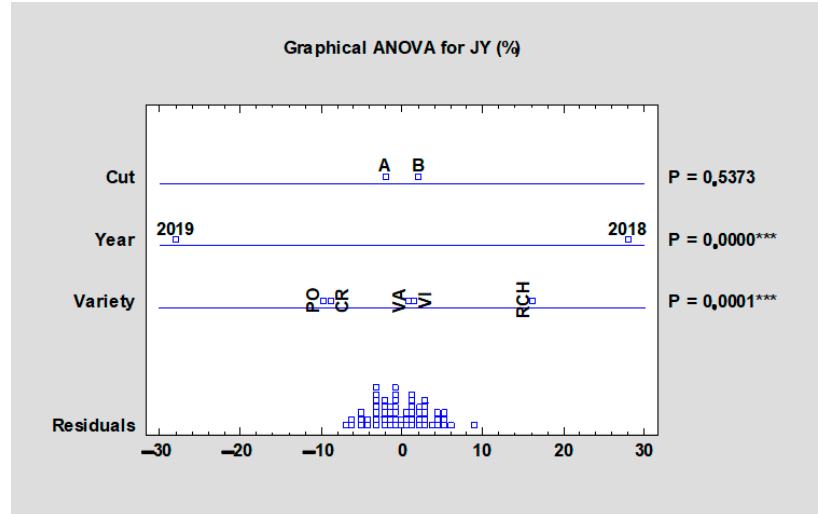
Figure 3. Effect of the experimental year, cultivar, and term of the harvest on the mean juice yield of all rhubarb cultivars. Abbreviations: PON, ´Poncho´; CRE, ´Canadian Red´; VAL, ´Valentine´; RCH, ´Red Champagne´; VIC, ´Victoria´. LSD test with significance: p ≤ 0.001 (***).